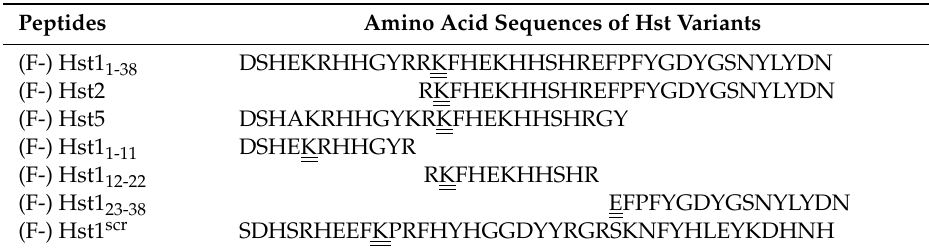
Table 1. Peptides Amino acid sequences of histatin 1 (Hst1 or Hst1 1-38 ) and its variants without or with fluorescent label